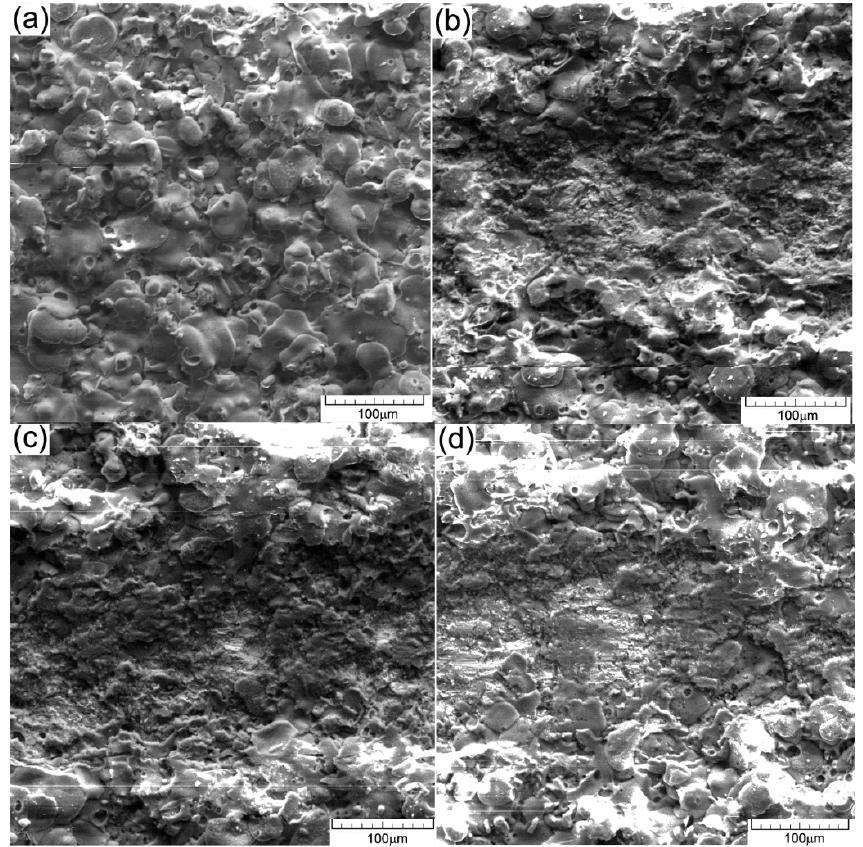
Figure 6. SEM images—details of the scratched areas on the ceramic coating ( a ) initiation of scratch, ( b ) first area of ceramic layer deformation, ( c ) local compaction of the ceramic layer and ( d ) end of the scratch mark.